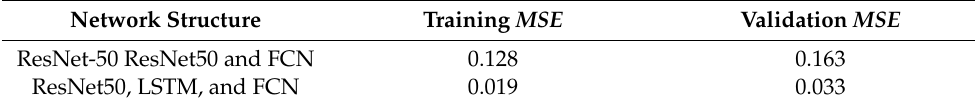
Table 2. Comparison of training and validation accuracy across different network structures.